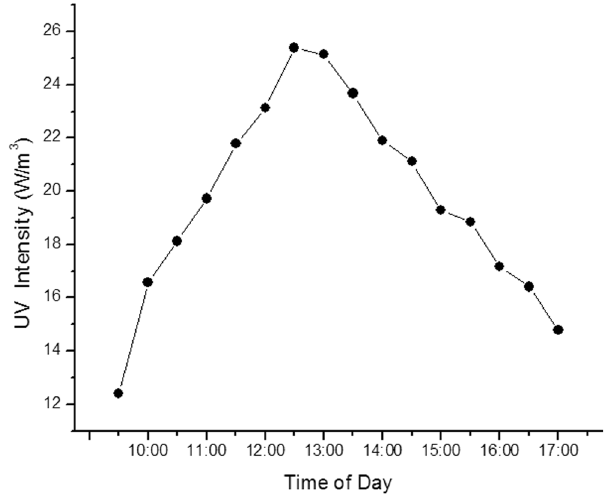
Figure 9. The fluctuation curve of sunlight UV radiation average in different hours of the day.